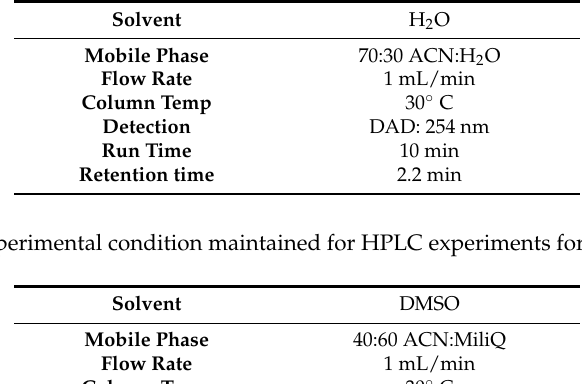
Table 1. Experimental conditions maintained for HPLC experiments for gemcitabine.